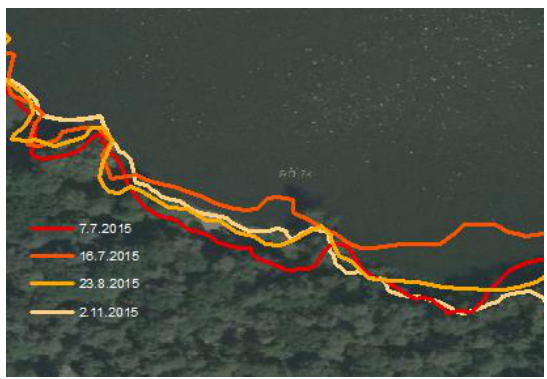
Fig. 5: Define shorelines for every monitoring, source: authors Extension of ArcGIS for Desktop – Image Analysis, is used for studying shoreline, and particularly their changes. This extension is used as a tool for supervised and unsupervised classification also. Supervised classification (Seed tool) and next creating polyline is available (see Figure 6). Unsupervised classification is available in the way shown by Figure 7. An approximate scale of figures 5,6 and 7 is 1 : 785 000 000. Next, resulting polygons are converted into polylines. Polylines must be repaired in both cases because shadows are visible in the images. Irregular texture is visible in both images. It decreases quality of classifications. In this case images must be repaired by observer. So, polylines created by observer are used for the following calculation of indices (Figure 5).